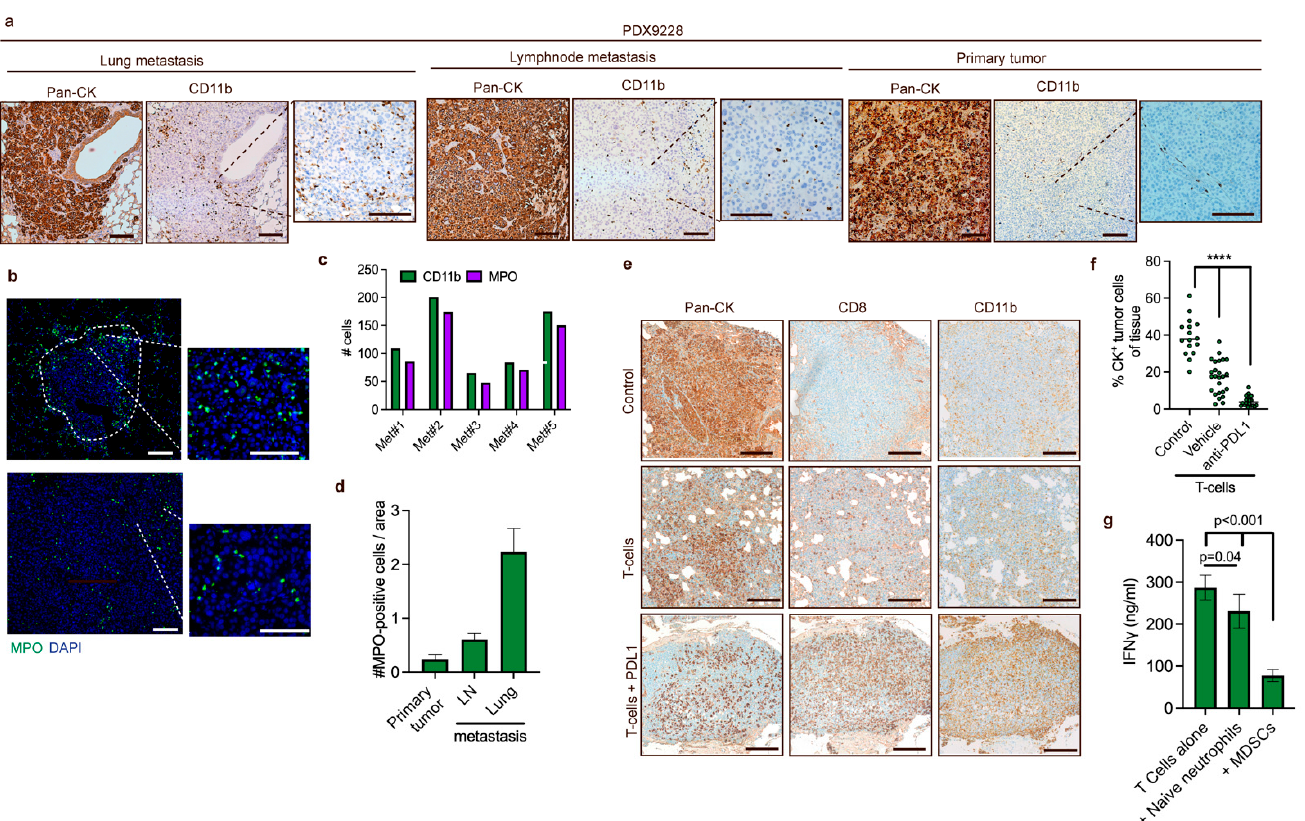
Figure 5. MDSCs are recruited to lung metastases, and recruitment is increased following T cell- induced inflammation ( a ) Representative IHC staining of spontaneous lung metastases in mice challenged with PDX9228 primary tumors. A pan-cytokeratin (Pan-CK) antibody was used to stain tumor cells, while a CD11b antibody was used to stain myeloid cells. ( b ) Representative immunos- taining of neutrophils (green, MPO) and DNA (blue, DAPI) in the lungs from mice challenged with PDX9228 primary tumors. The tumor-stroma interface is outlined with a white dashed line. ( c ) Quantifications of CD11b-positive cells represented in ( a ) and MPO-positive cells represented in ( b ) in parallel sections of five metastases from the lungs of mice bearing PDX9228. Data are presented as the number of CD11b-positive (green bar) and MPO-positive (purple bar) cells that were counted manually in the same metastases. ( d ) MPO-positive cells were counted manually in four different randomly selected areas of primary (n = 1) and lymph node tissue (n = 1), and in four different randomly selected lung metastases (n = 1). The data are presented as the mean number of MPO-positive cells relative to the area +/ − SD. ( e ) Representative images of metastasis from mice. Following establishment of metastases from tail-vein injection of MDA-MB-231 cells, mice were treated with either partly HLA-matched human T cells and anti-PDL1 antibody (T cells + PDL1) or anti-PDL1 antibody alone (control). ( f ) Quantifications of cytokeratin-positive cells represented in ( e ). Each dot represents a randomly selected lung metastasis. Data are presented as the percentage of cytokeratin positivity in each metastasis. ( g ) ELISA analysis of secreted IFN γ from T cell supernatants on 48h incubation with CD3/CD28 beads (at a cell-to-bead ratio of 1:1), naïve neutrophils from non-tumor-bearing mice (at a T cell-to-neutrophil ratio of 1:3), and MDSC from tumor-bearing mice (at a T cell-to-neutrophil ratio of 1:3). The statistical difference was determined by one-way ANOVA followed by Bonferroni’s multiple comparison testing. **** p < 0.0001. Scale bars: 200 µ